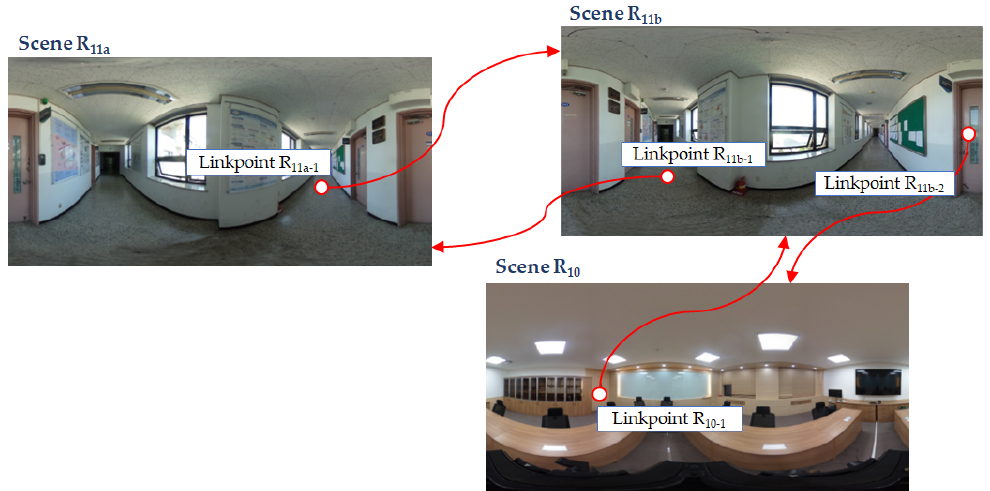
Figure 5. Defining the connections between the omnidirectional images through linkpoints.